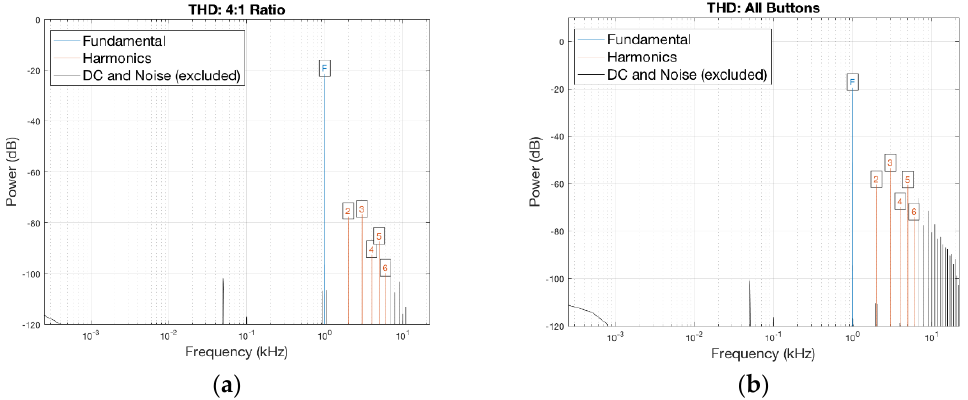
Figure 3. ( a ) Distortion components created using a 4:1 ratio and attack at three and release at seven; ( b ) distortion components created using the all-buttons ratio and attack at three and release at seven.